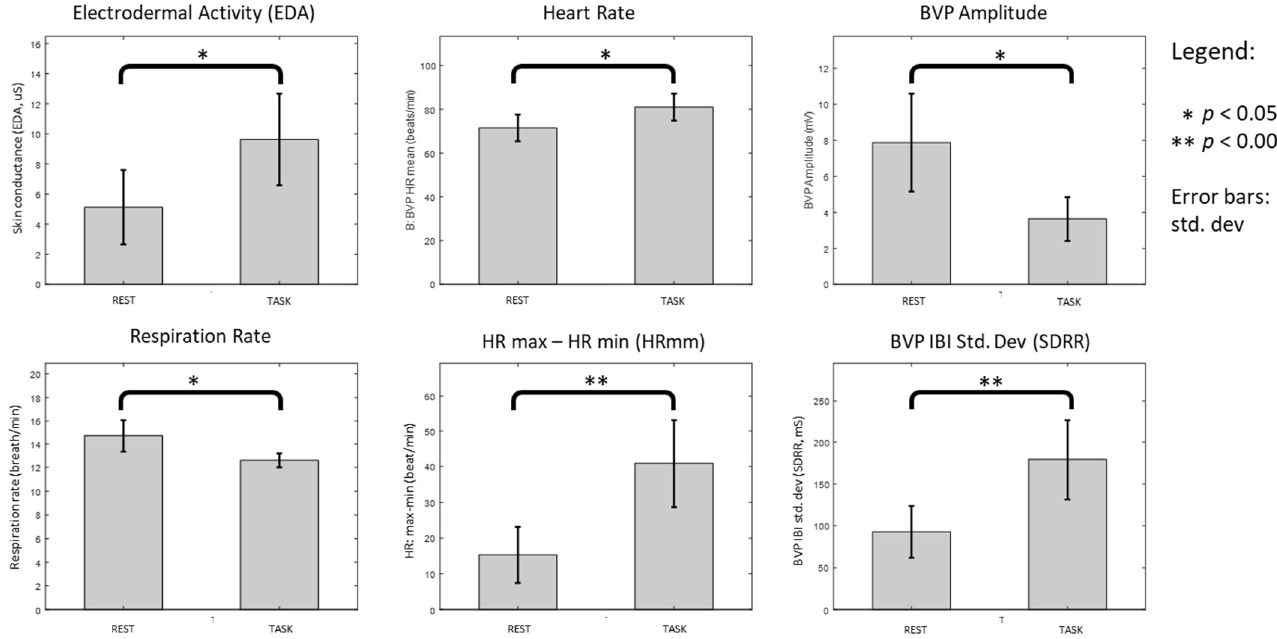
Figure 2. Physiological markers during speech task (TASK) were significantly different as compared to baseline (REST).